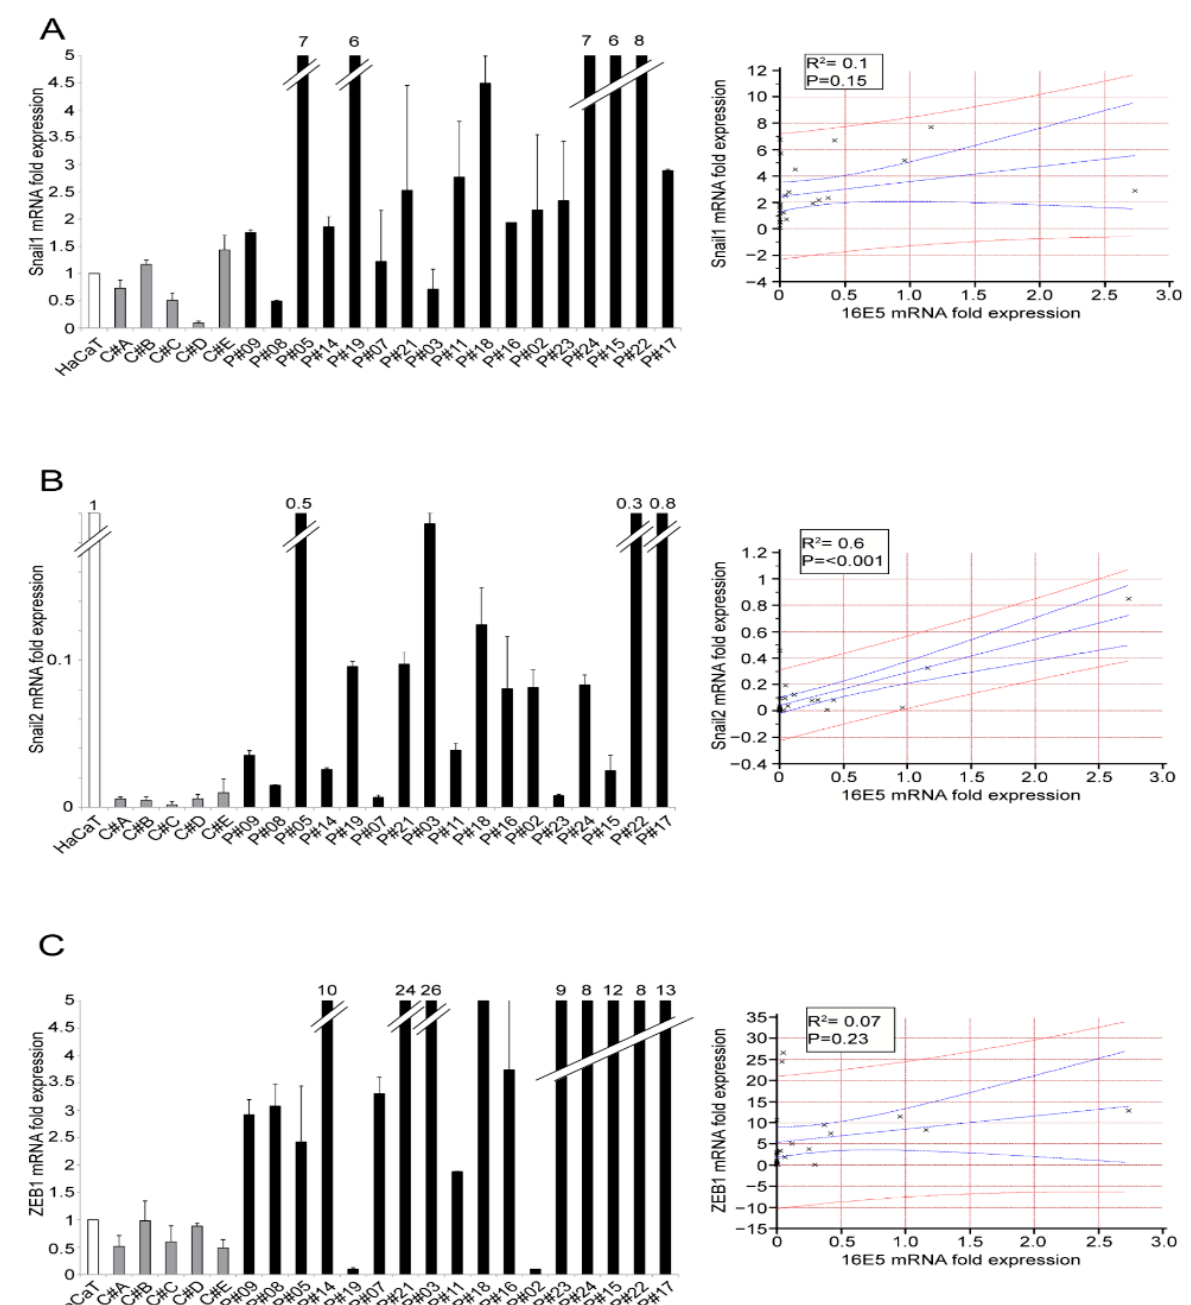
Figure 3. Expression of EMT-related transcription factors in LSILs. Snail1 ( A ), Snail2 ( B ) and Zeb1 ( C ) mRNA levels were evaluated by real-time PCR in LSILs and normalized with respect to HaCaT cells. Results are expressed as mean values ± SD. The relationships between the variables are expressed in the scatter diagrams in which HPV16E5 expression levels are plotted on the horizontal axis and the Snail1, Snail2 and ZEB1 expression levels are plotted on the vertical axis. The regression line ± 95% confidence limits are shown in blue, and the ± 95% prediction bands are in red. R 2 : Pearson’s correlation coefficient value.